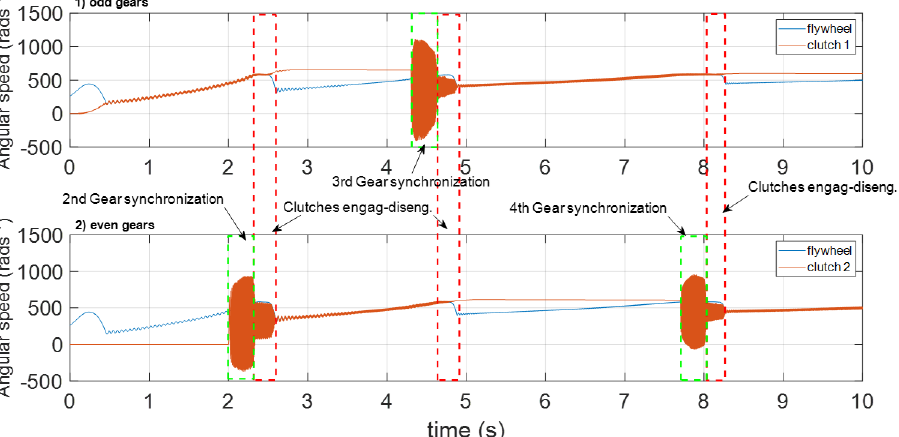
Figure 9. Angular speed of flywheel and clutches during a run-up transient for case (a): (1) odd gears; (2) even